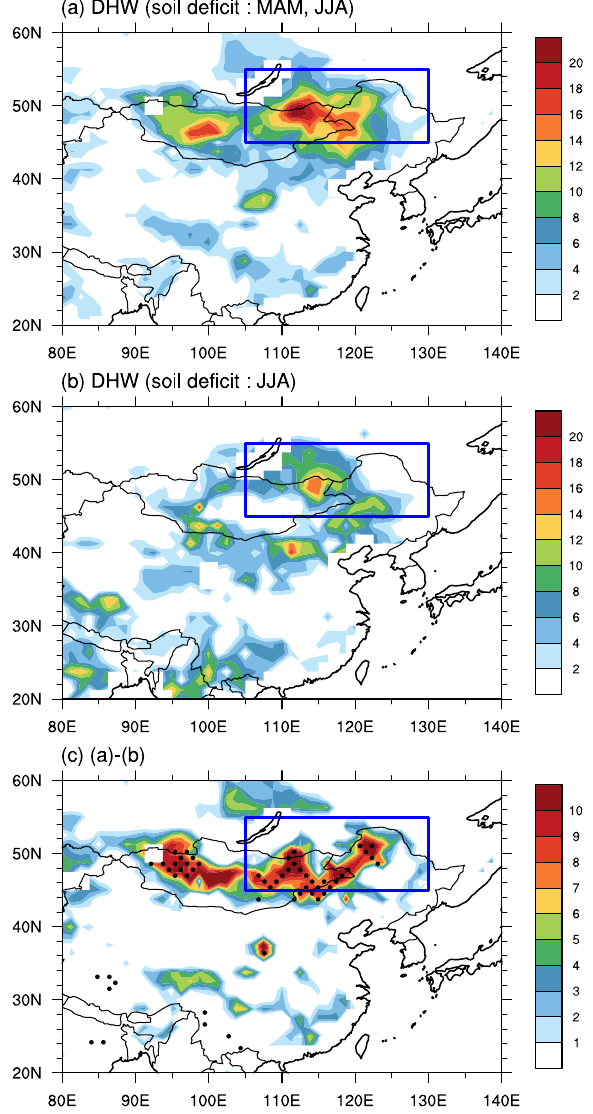
Fig. 5 Composite map of DHW during soil moisture de fi cient years. Composite maps of DHW (days year − 1 ) for ( a ) persistent soil moisture de fi cient years from spring to summer and ( b ) summer soil moisture de fi cient years, and ( c ) difference between ( a ) and ( b ). The dots denote the 90% con fi dence level based on the P